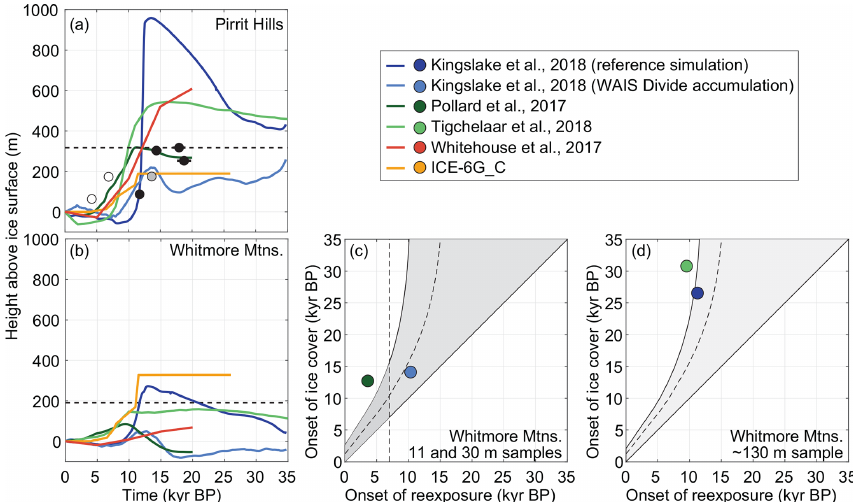
Figure 7. Evaluation of ice-sheet models at the Pirrit Hills and Whitmore Mountains. Panels (a) and (b) show ice-thickness histories from five ice-sheet models at the Pirrit Hills and Whitmore Mountains, respectively. The horizontal dashed line in panel (a) represents the height of the highstand, while in panel (b) it represents the upper limit of the highstand. Panel (a) also depicts 10 Be exposure ages as in Fig. 5a. Panel (c) shows chronological constraints on exposure and ice cover from the two lowest elevation bedrock samples. The gray areas are permitted by the bedrock 14 C data, and the vertical dashed line represents the earliest time (7kyrBP) that the modern ice level could have been reached at the Whitmore Mountains. Refer to the caption of Fig. 6 for a full explanation of this figure. Panel (d) shows the same constraints, except from the bedrock sample ∼ 130m above the ice surface. In comparison to the lower samples, the ∼ 130m sample provides slightly more restrictive constraints on ice cover and exposure. For panels (c) and (d) , only models that simulate both cover and reexposure of the sample(s) within the past 35kyr appear on the